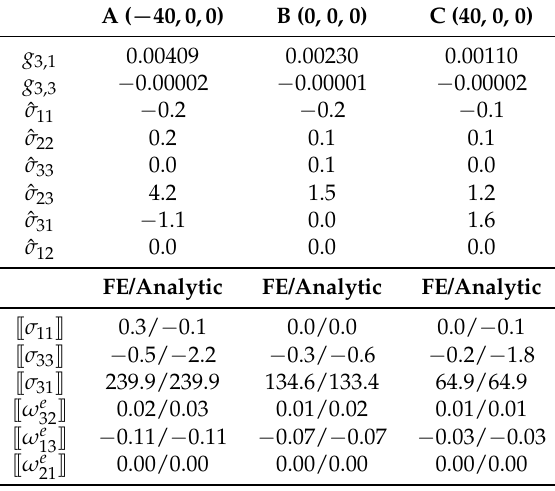
]] (MPa) and [[ ω e ]] ( ◦ ) given by the FE ∼ ∼